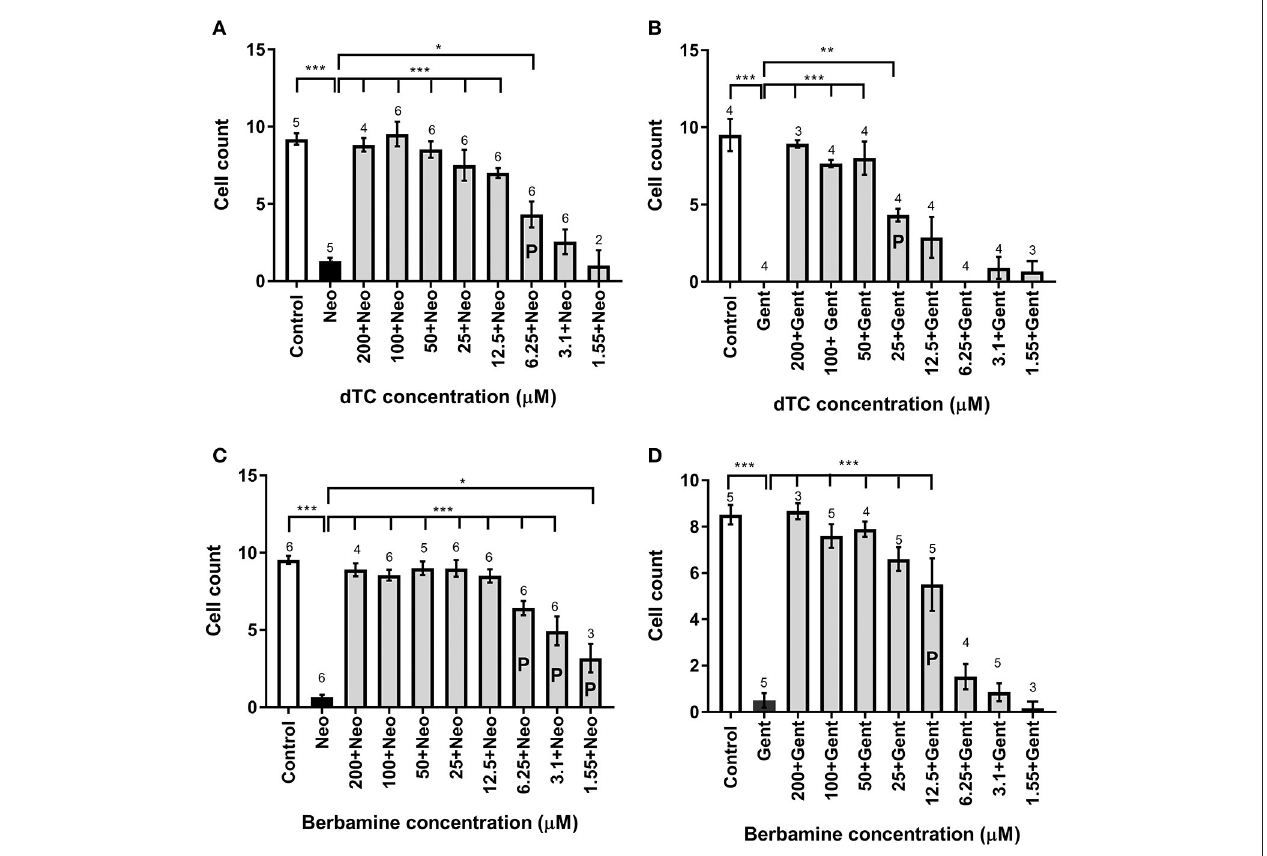
FIGURE 2 | Cell count analysis for lateral line hair cell protection against gentamicin and neomycin by d-tubocurarine and berbamine. (A–D) A range of concentrations (1.55–200 µ M) of either dTC or berbamine with either neomycin or gentamicin are compared to neomycin or gentamicin alone. Number of hair cells were counted in trunk neuromast 4. (A) dTC against neomycin, (B) dTC against gentamicin, (C) berbamine against neomycin and (D) berbamine against gentamicin. Cells counts that are significantly different from aminoglycoside alone are indicated above the bars, with the number of stars representing the level of significance. The letter P in the bars indicates concentrations that were deemed partially protective, because cell counts were also significantly different from the control (A: ***; B : ***; C : ***; D : **). Numbers above the bars indicate experimental replicates, with cell numbers in three neuromasts counted and averaged for each replicate. * p < 0.05; ** p < 0.01; *** p <